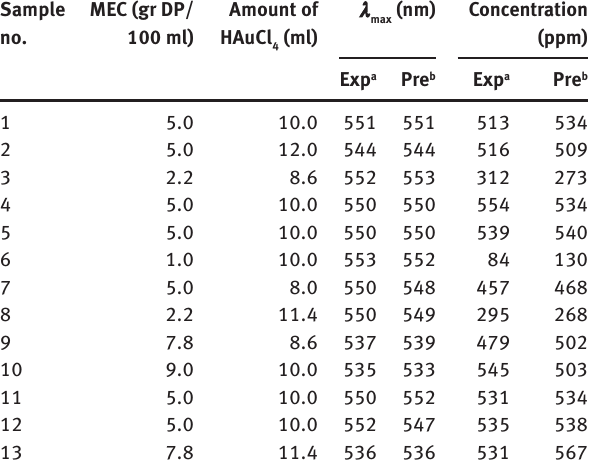
Table 1: Central composite design and response variables ( experimental and predicted value) for synthesis of gold nanoparticles using mushroom